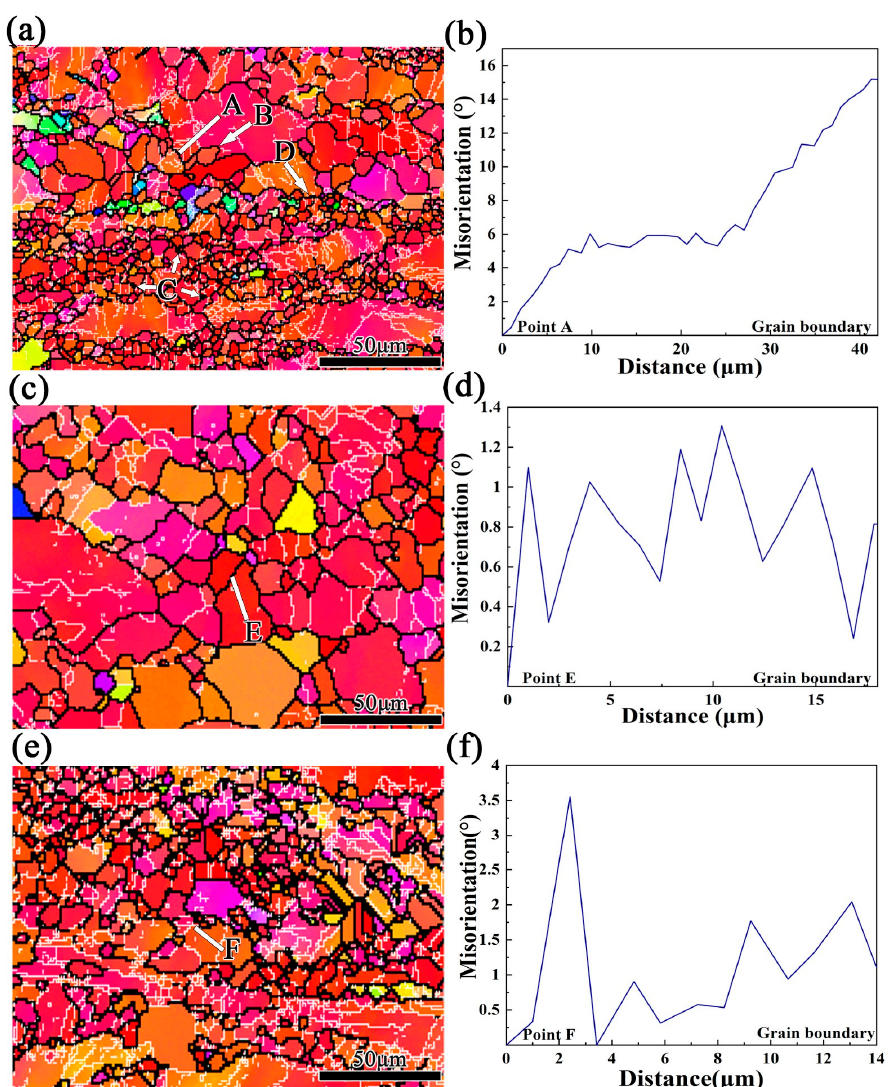
Figure 18. The EBSD diagrams and misorientation profiles along the line marked of Mg-3Bi alloy under different conditions: ( a , b ) 573 K and 0.01 s − 1 , ( c , d ) 623 K, and 0.01 s − 1 , ( e , f ) 573 K and 0.1 s − 1 , respectively.